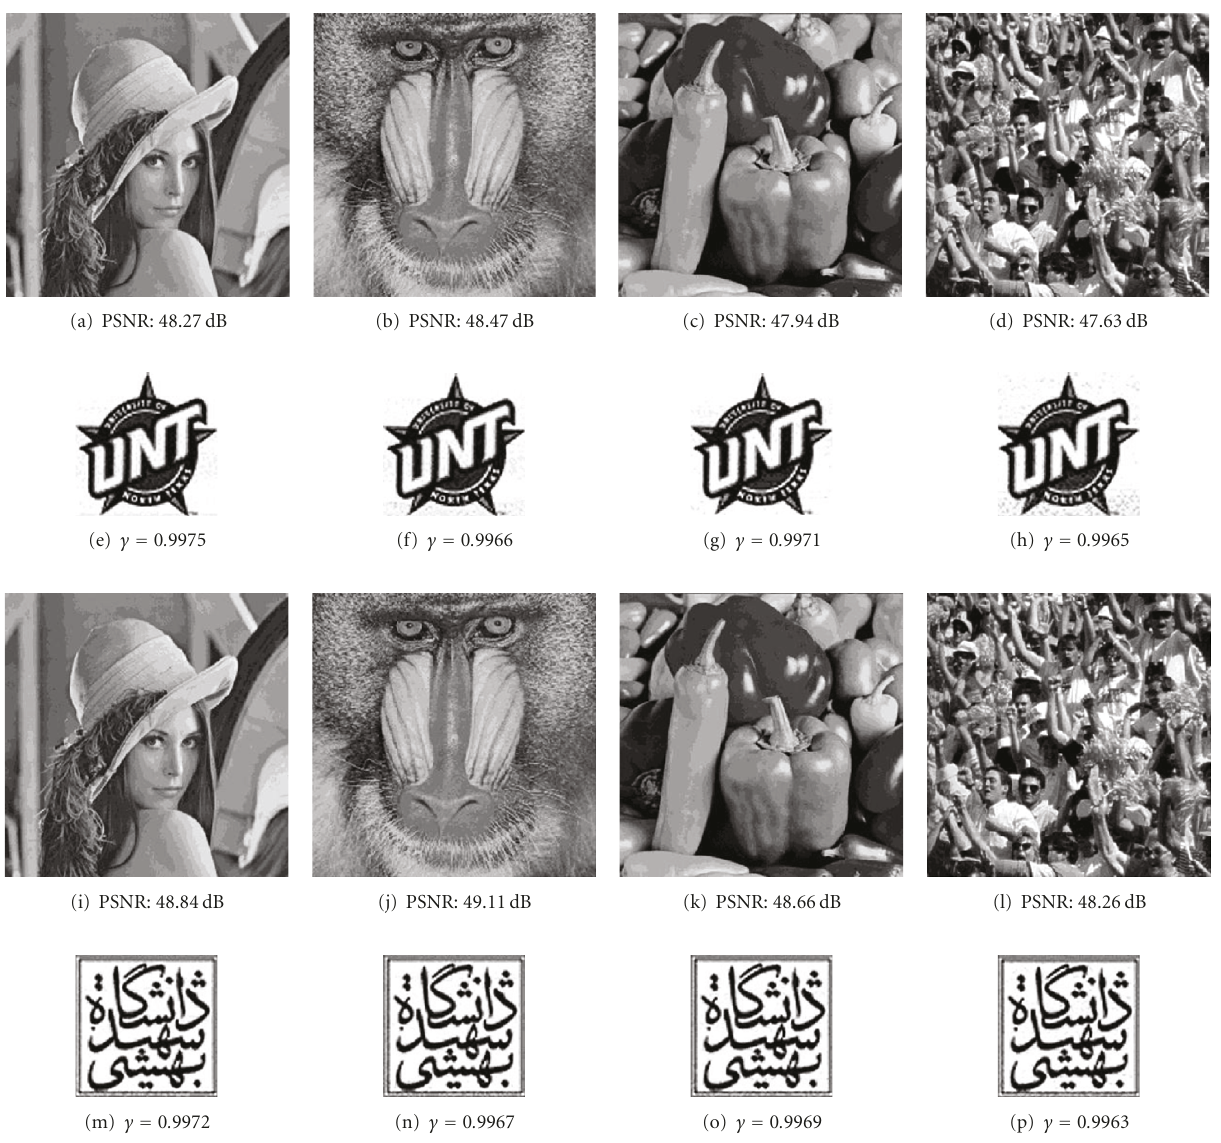
Figure 13: (a)–(d) Watermarked images after embedding 256 × 256 watermark image as shown in Figure 11(b). (e)–(h) Extracted watermarks from (a)–(d), respectively. (i)–(l) Watermarked images after embedding 256 × 256 watermark image as shown in Figure 11(d). (m)–(p) Extracted watermarks from (i)–(l),